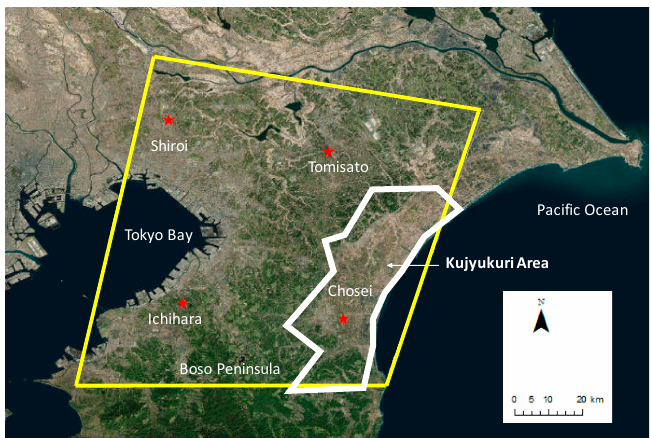
Figure 1. Location of the study site (yellow box). The red stars indicate GeoNET stations.